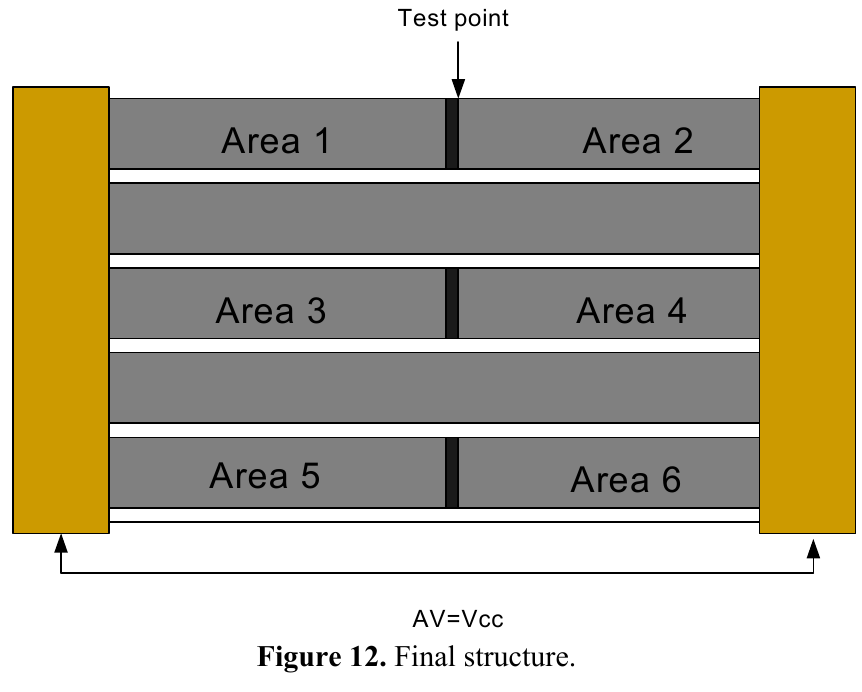
Figure 12. Final